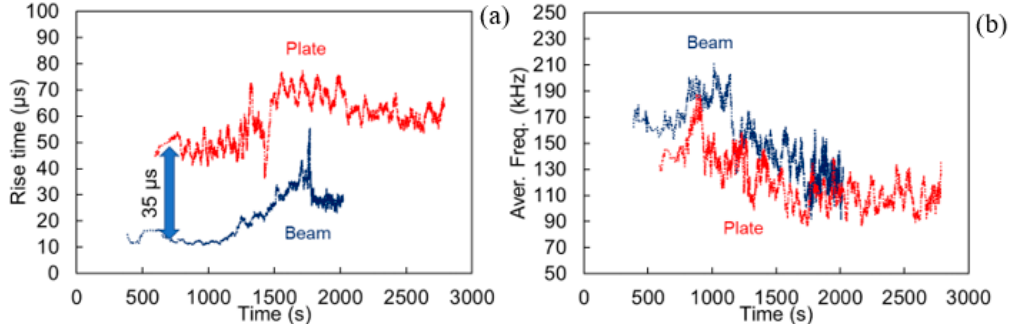
Figure 10 . ( a ) Rise time and ( b ) average frequency vs. time of test. The lines are sliding averages of 200 successive data points.